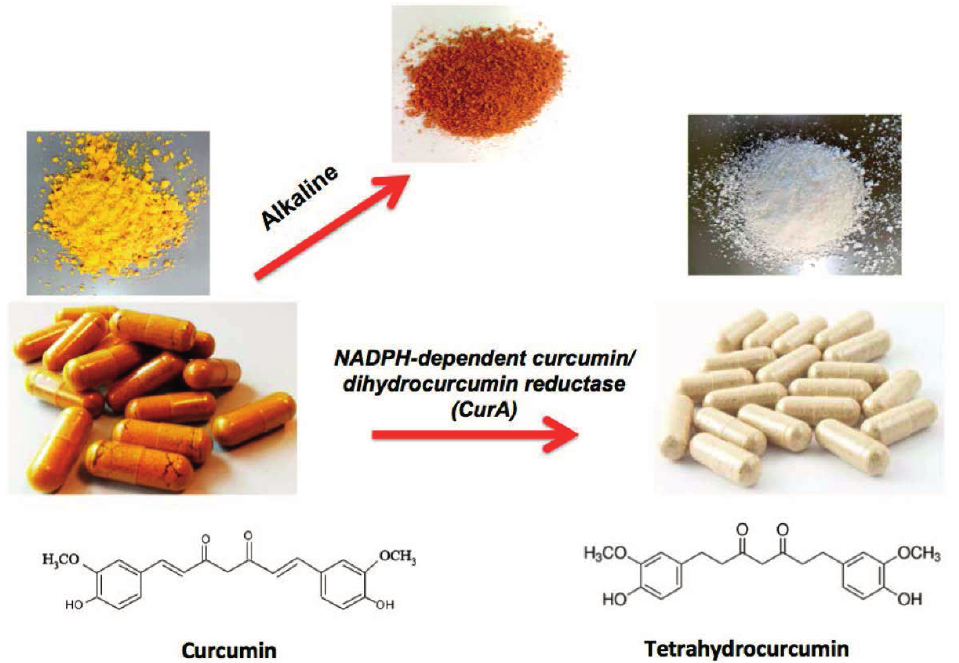
Figure 1. With increasing pH (alkalinity), curcumin changes to red. Curcumin metabolically converts to tetrahydrocurcumin by using the NADPH-dependent curcumin/dihydrocurcumin reductase (CurA) enzyme. Structurally, curcumin has the α,β-unsaturated carbonyl group, but tetrahydrocurcumin lacks α,β